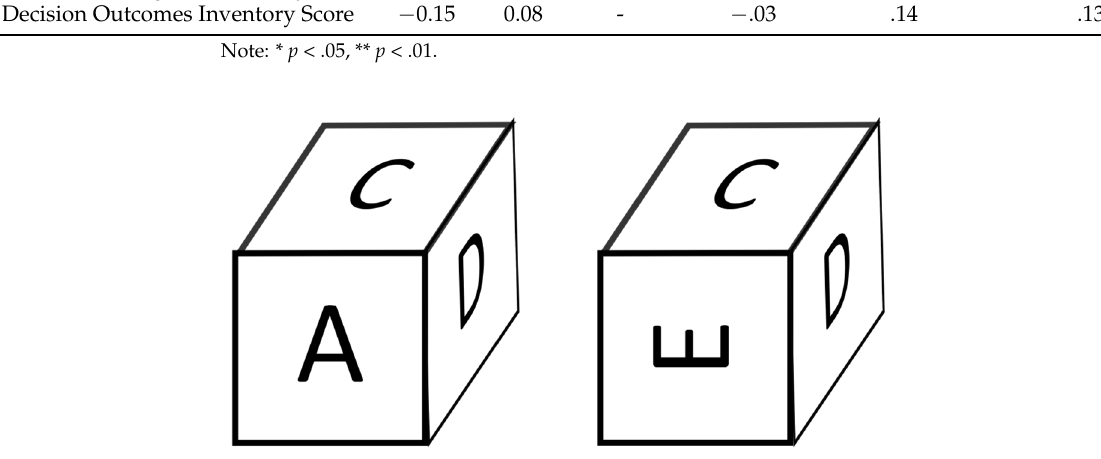
Figure A1. Pseudo-example item for the Cube Comparisons Task. In this example, the two cubes must be different, as the A and E occupy the same position (below the C, and to the left of the D), and any letter can only appear once on each cube.